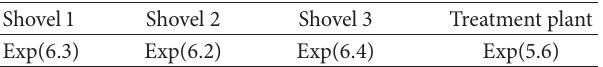
Table 2: Time (minutes) for load/unload the mineral to/from the truck.